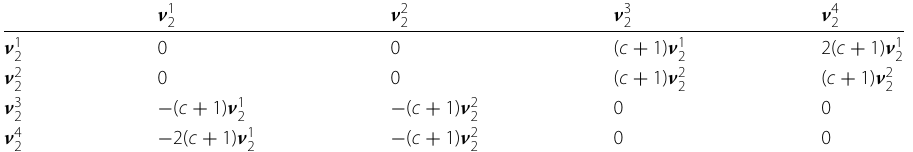
Table 2 Commutator table of the Lie algebra of Eq.